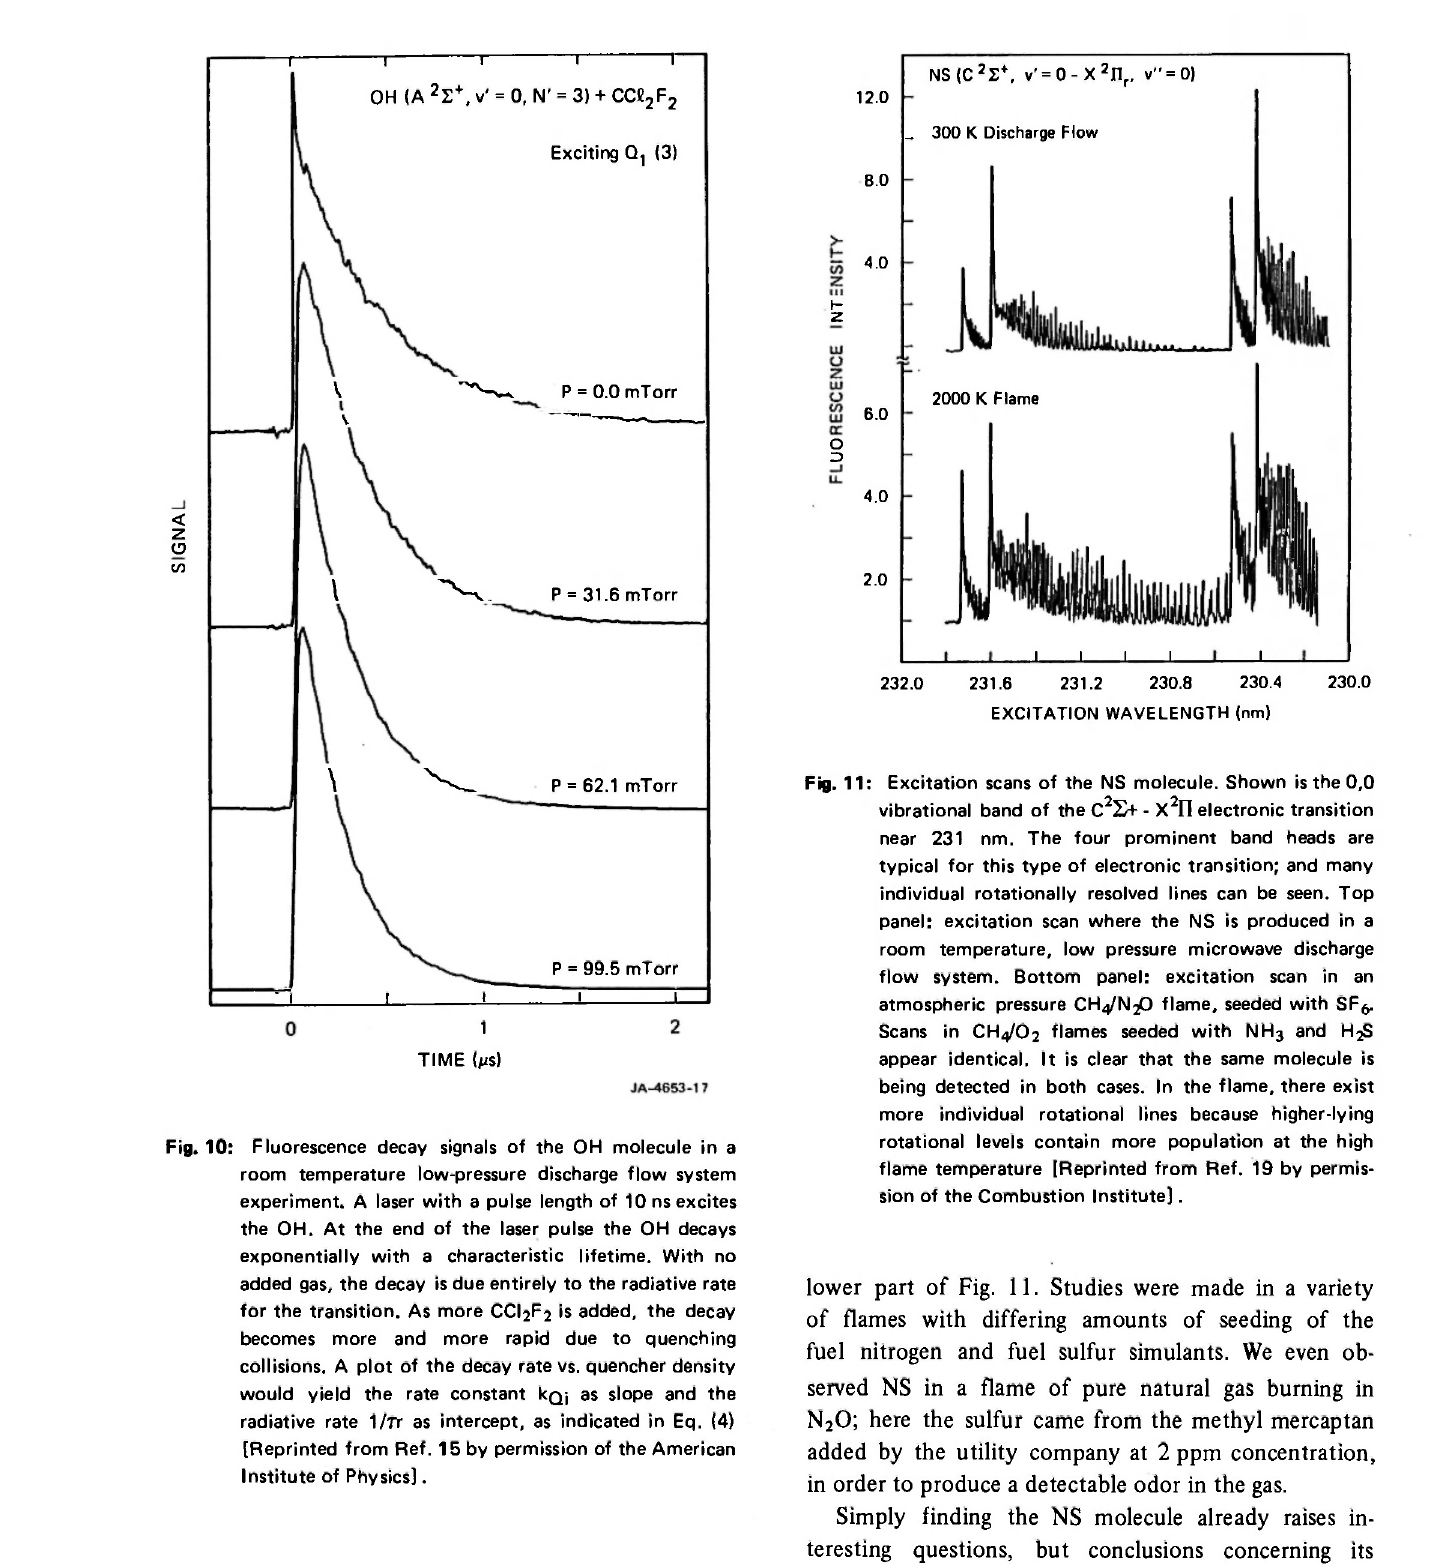
Fig. 11: Excitation scans of the NS molecule. Shown is the 0,0 vibrational band of the 0 2 Σ+ - Χ 2 Π electronic transition near 231 nm. The four prominent band heads are typical for this type of electronic transition; and many individual rotationally resolved lines can be seen. Top panel: excitation scan where the NS is produced in a room temperature, low pressure microwave discharge flow system. Bottom panel: excitation scan in an atmospheric pressure CH^/N^O flame, seeded with SF^ Scans in CH4/O2 flames seeded with NH3 and H2S appear identical. It is clear that the same molecule is being detected in both cases. In the flame, there exist more individual rotational lines because higher-lying rotational levels contain more population at the high flame temperature [Reprinted from Ref. 19 by permis- sion of the Combustion